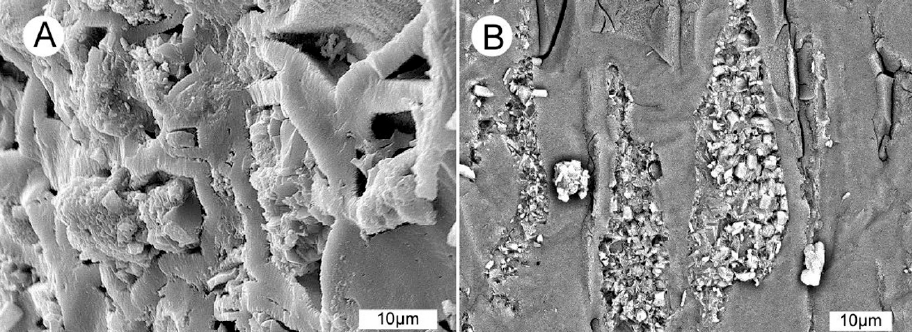
Figure 21. Accessory minerals in opalized wood. ( A ) Specimen T-25 (trunk 12). Cell walls are mineralized with opal, lumen contain crystalline gypsum. ( B ) Specimen T-9 (trunk 5). Opalized wood with lumen filled with blocky crystals of calcium phosphate (apatite or